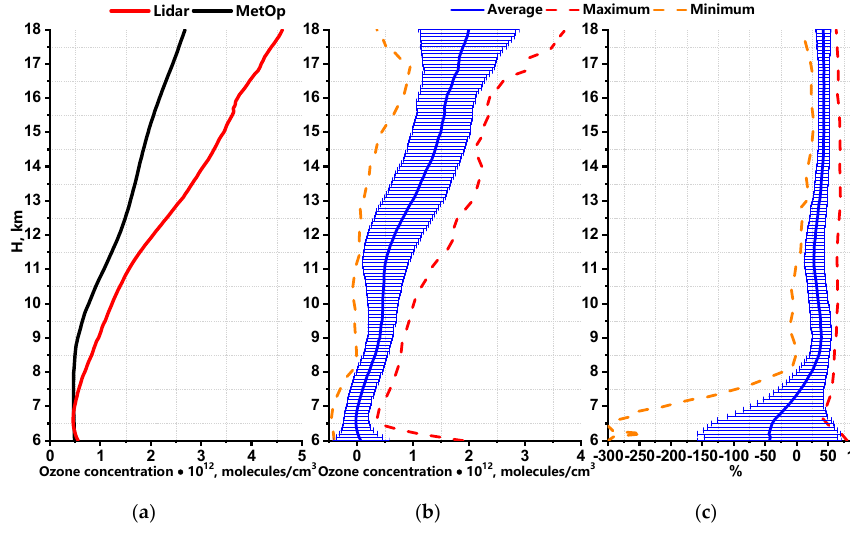
Figure 5. Average OVDs and their differences: ( a ) average profiles; ( b ) differences between the lidar and MetOp data, in absolute units; ( c ) relative differences 100 × (lidar − MetOp )/lidar.